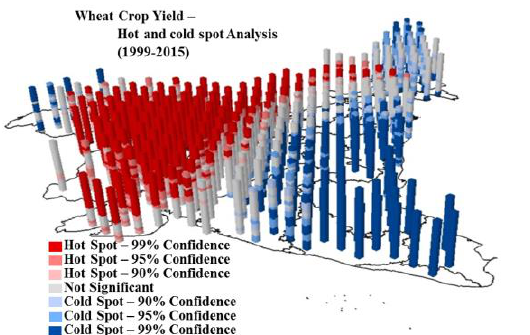
Figure 17 . Three dimensional changes in Hot and cold spot map of wheat crop